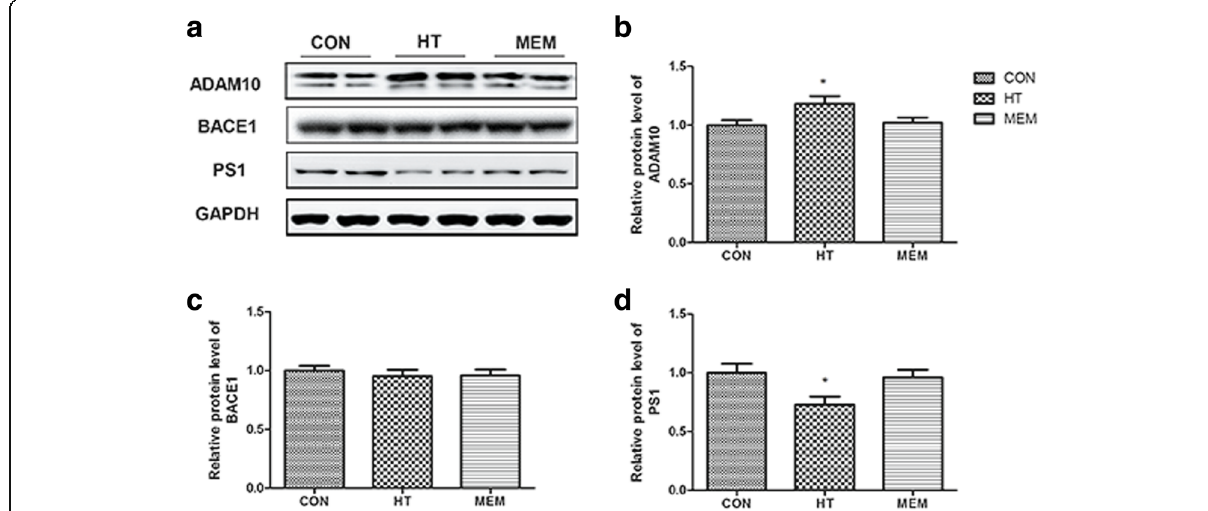
Fig. 8 Effects of HT on the enzyme activities of α -secretase, β -secretase, and γ -secretase. a The protein levels of ADAM10, Beta-secretase 1 (BACE1) and PS1 were measured by Western blotting in the different groups. b Quantitative analysis of ADAM10 expression. * P < 0.05 versus control group; c Quantitative analysis of BACE1 expression. d Quantitative analysis of PS1 expression. * P < 0.05 versus control group. All data are expressed as the means ± SEM, Significant differences * P < 0.05 compared to the control group, n = 6 per